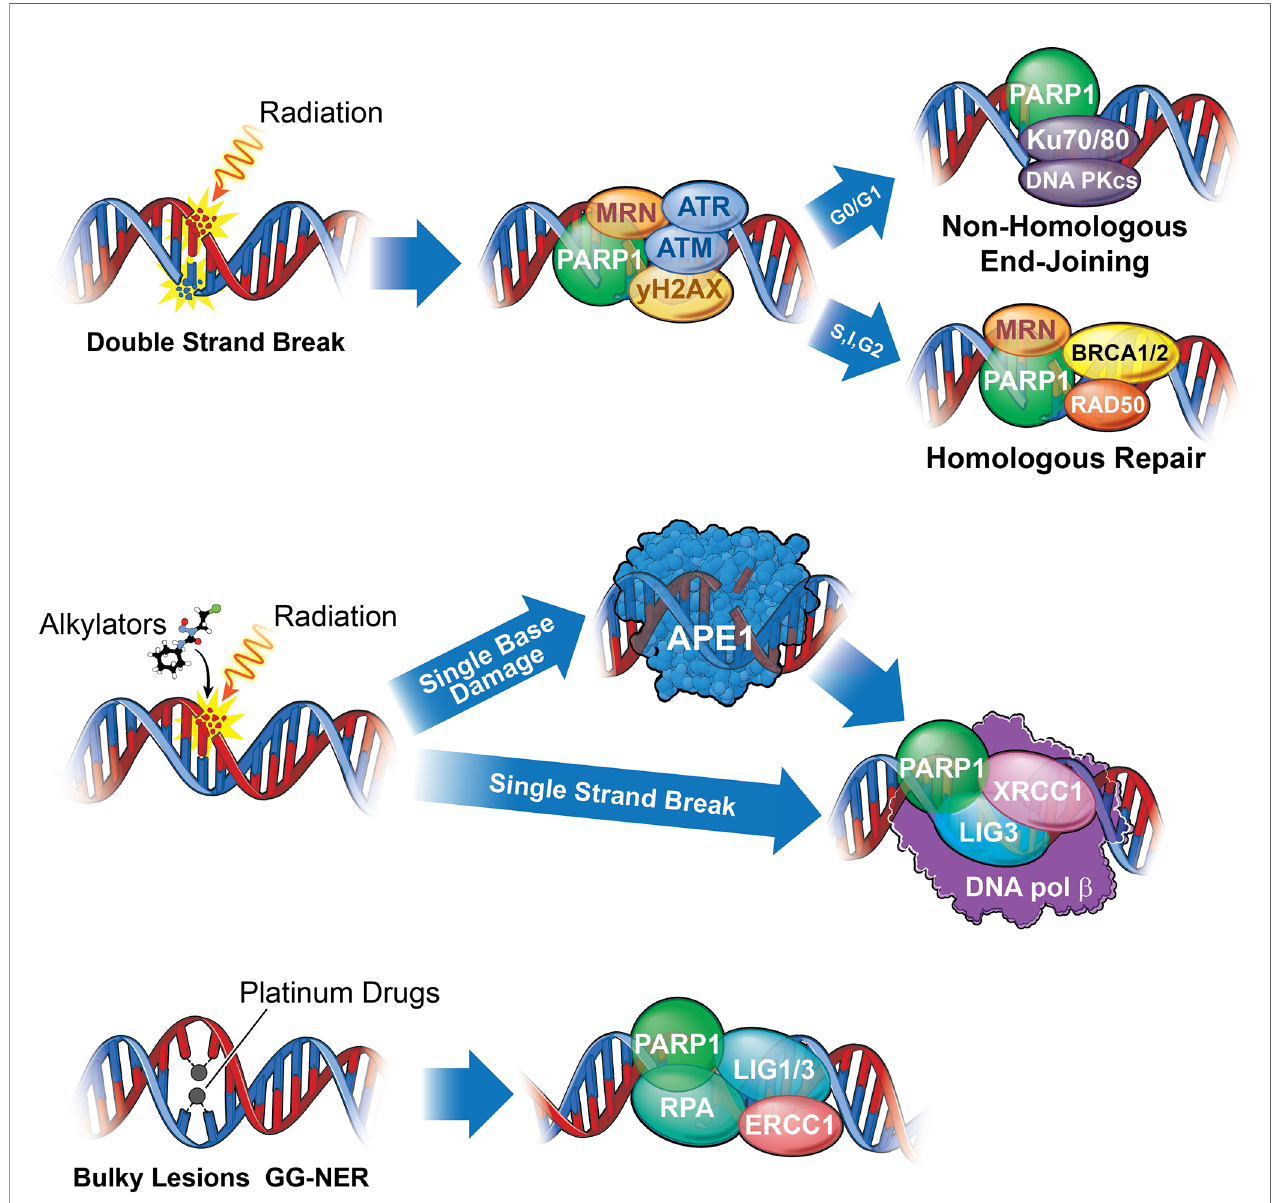
FIGURE 2 | A summary of the DNA damage response in medulloblastoma. Numerous DNA damage response signaling axes mediate DNA repair following medulloblastoma standard of care. Chemotherapies utilized, including temozolomide, cisplatin, lomustine, and cyclophosphamide (with cisplatin and cyclophosphamide constituting standard of care), bind directly to DNA to create bulky lesions repaired through a combination of either Base Excision Repair (BER), Nucleotide Excision Repair (NER), MGMT (Not shown), and HR or NHEJ, while IR mediated DSBs are repaired through NHEJ and HR. (Top) The deleterious effects of Ionizing radiation results primarily from DNA double strand breaks (DSBs) repaired either through Homologous Repair (HR) or Non-Homologous End Joining (NHEJ). While PARP, M/R/N (a complex of 3 proteins: MRE-11, RAD50, NBS), and ATM function universally to recognize strand breaks, cells in G0/G1 lack sister chromatids and will repair through a more error prone NHEJ, while those in S, Interphase, or G2 will repair through HR, utilizing the sister chromatid to replace the missing bases. Proteins directly involved in repair of double strand breaks include Ku70/80 and DNA-PKcs for NHEJ and M/R/N, BRCA1/2, and RAD50 for HR. Upstream effectors, ATM and ATR, will signal through Chk1 and 2 to arrest the cell and either repair or commit apoptosis ( Figure 4 ). (Middle) Single strand breaks resulting from radiation or excision of damaged base pairs by APE1 (such as those resulting from alkylation) are identi fi ed by PARP1 and repaired by XRCC1, DNA Ligase III (LIG3), and DNA Polymerase b . (Bottom) Bulky lesions resulting from platinum-based drugs such as cisplatin or carboplatin can be repaired either through transcription coupled NER (TC-NER) or global genomic NER (GG-NER). While it remains unclear what role PARP may play in TC-NER, it serves as a recognition and recruitment protein for GG-NER, functioning alongside DNA Ligase I or III (LIG1/3), RPA, and ERCC1 proteins. Bifunctional alkylating agents and chloro-ethylating agents, such as cyclophosphamide or lomustine, respectively, can methylate guanine. Methylated guanine can be repaired through MGMT (not shown), through direct removal of guanine methyl group, potentially resulting intrastrand cross-linking (ICL) requiring a combination of NER and HR or NHEJ to repair) or interstrand cross-linking, repaired through NER. Platinum drugs mediate interstrand cross-linking, repaired predominantly through NER. Finally, temozolomide can be repaired either through BER (requiring APE1) or MGMT